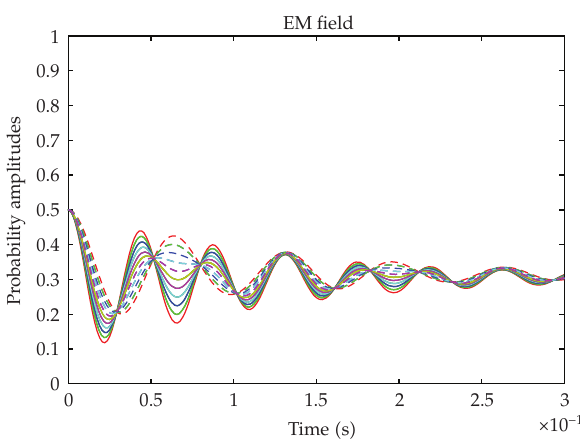
Figure 16: Right and left circular polarization prob. amplitudes for small Δ